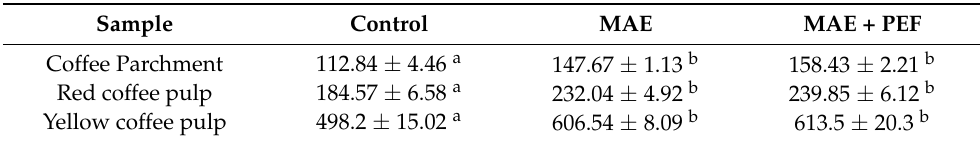
Table 2. Effect of the different treatments on caffeic acid content of Coffea arabica pulp and parchment detected by HPLC ( n =